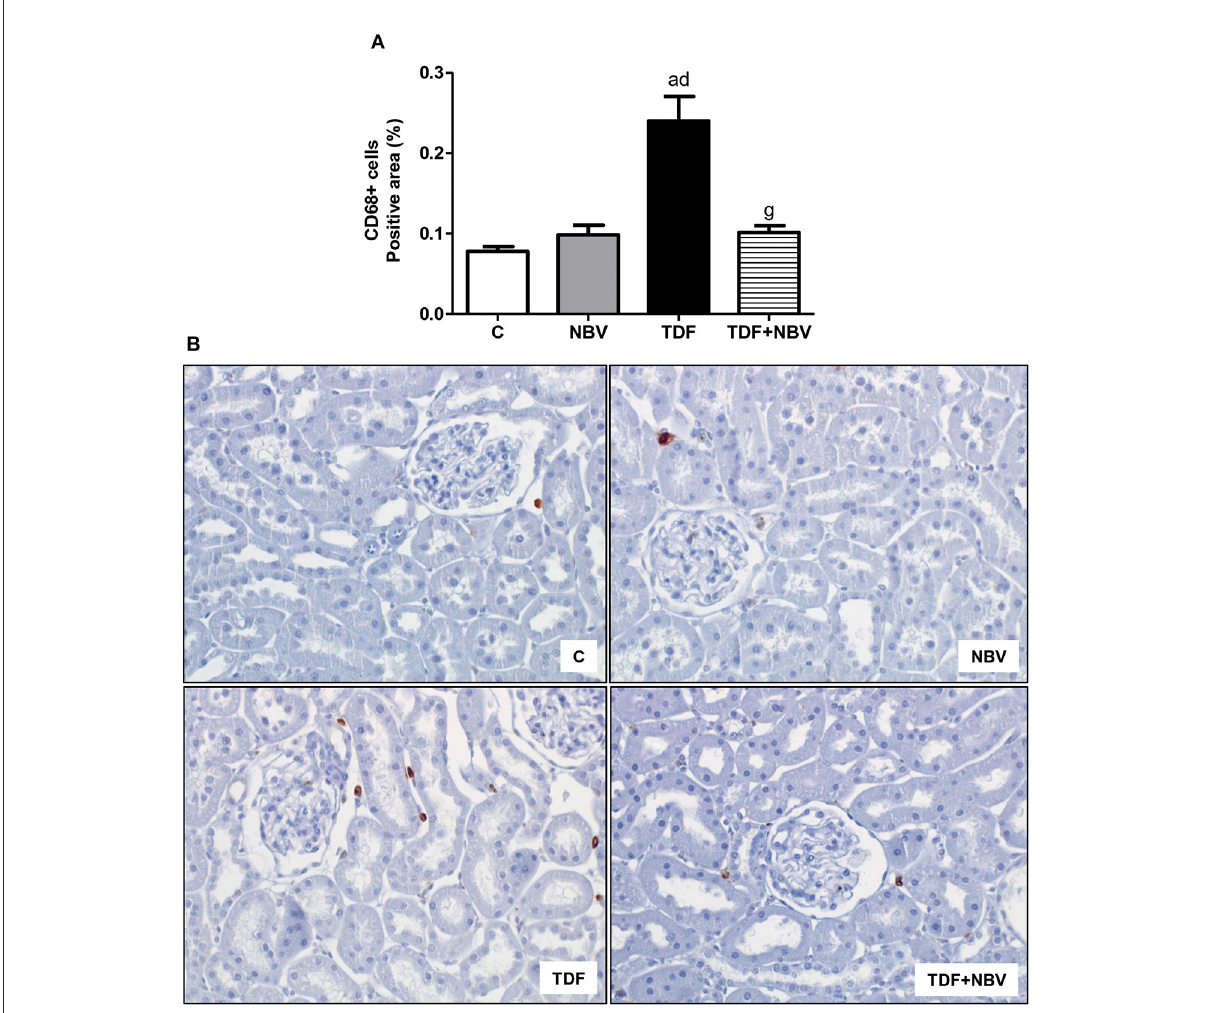
FIGURE4 Immunohistochemical analysis for CD68 + cells expression in rat kidney tissue. (A) Bar graph of CD68 positive cells expression values. (B) Representative photomicrographs of immunostaining for CD68 positive cells in the renal cortex from a C ( n = 7), NBV ( n = 7), TDF ( n = 8) and TDF + NBV ( n = 8) rat ( × 400). Values are means ± SEM. a p < 0.001 vs. C; d p < 0.001 vs. NBV; g p < 0.001 vs. TDF. C, control; NBV, Nebivolol; TDF,